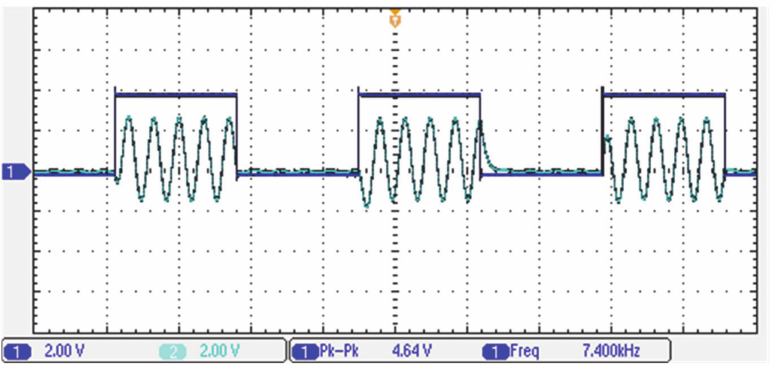
Figure 32. The measurement result of the ASK signal generator using pulse wave input